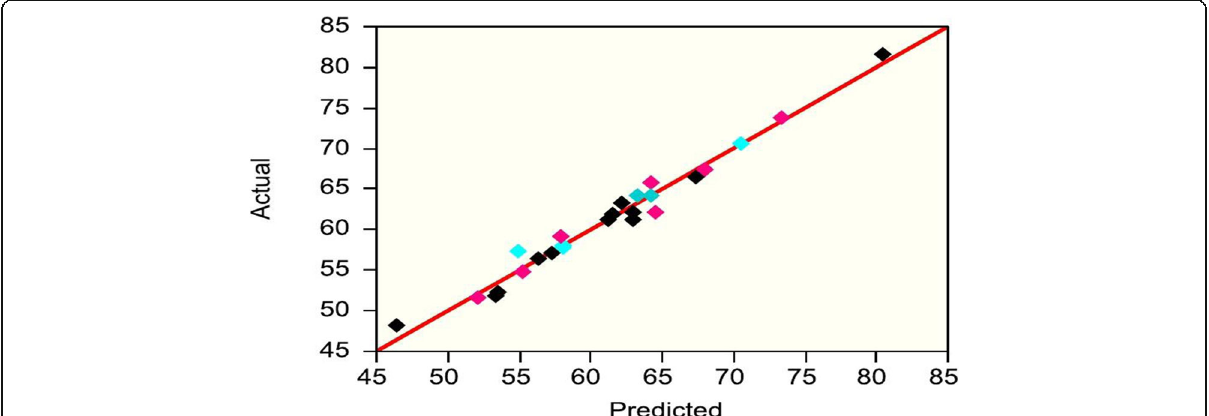
Fig. 5 CCD for the relation between actual and predicted α -amylase immobilization yield